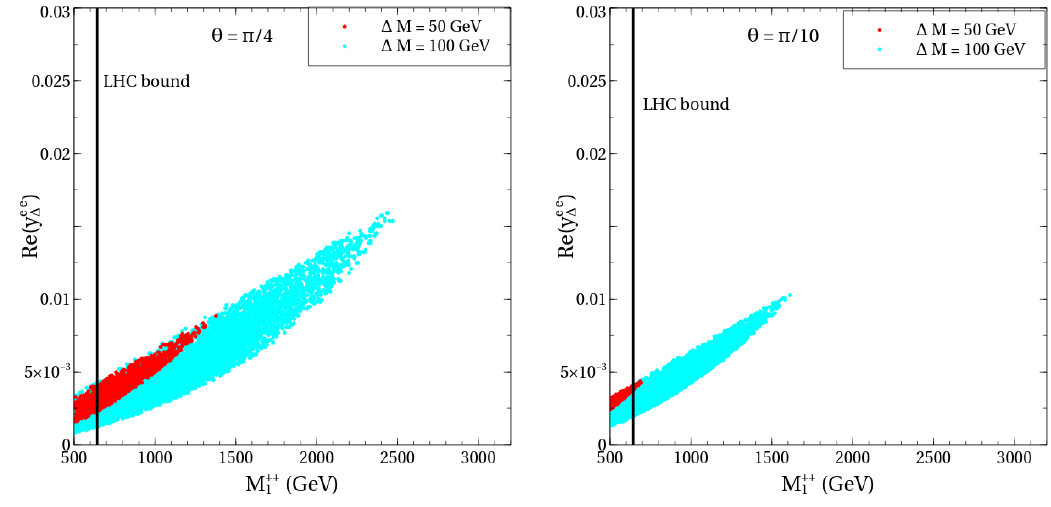
Figure 13 . Scatter points maintaining (cid:1) a (cid:22) within its 2 (cid:27) range and BR (cid:28) ! (cid:22) (cid:22)ee within the quoted limit plotted in the M ++ Re( y ee ) plane for (cid:18) = (cid:25) (left) and (cid:25) (right). A normal neutrino mass 1 (cid:0) (cid:1) 4 10 hierarchy is assumed. The color coding is explained in the legends. The region left to the black line is disallowed by dilepton searches at the LHC.